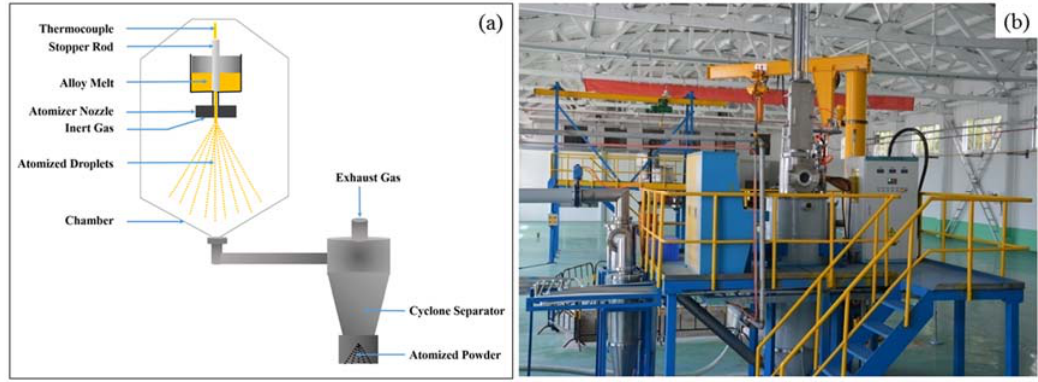
Figure 1. ( a ) Schematic drawing describing the principal of gas atomization technique and ( b ) set-up of the facility used in this work.